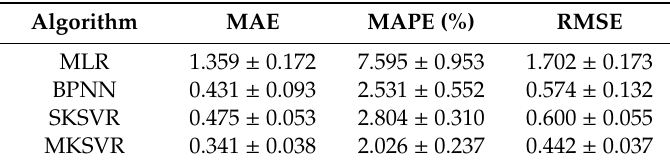
Table 3. FFA estimation (average ± SD) results of the four